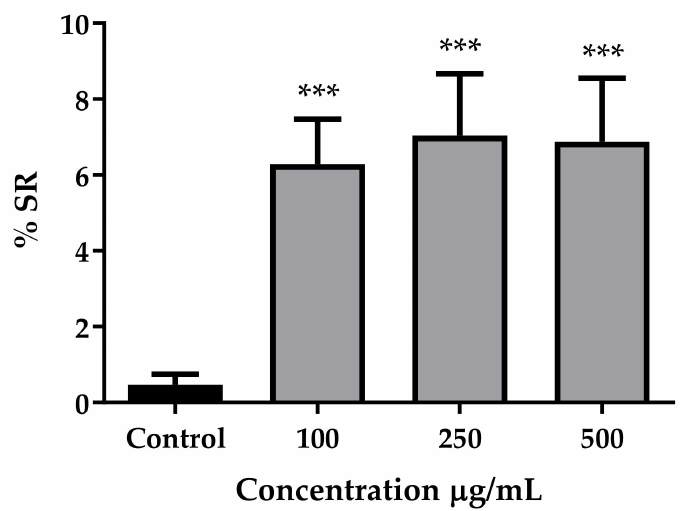
Figure 2. Survival Rate (SR) (%) of C. elegans after juglone-induced oxidative stress. The different populations were treated with different concentrations of guarana 100 ( n = 431), 250 ( n = 405) and 500 ( n = 321) µ g/mL prior to juglone challenge. Non-treated populations were used as control ( n = 438). Data are presented as the mean and SEM of survival percentage (*** p < 0.0001; Student’s t